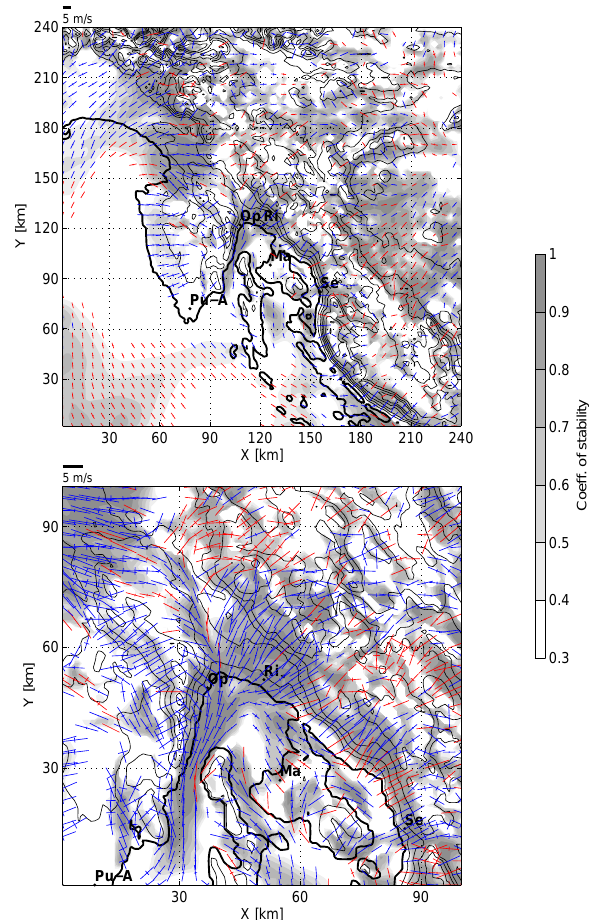
Fig. 9. The axes of averaged ellipses for four modeled multi-day intervals, outer domain (top), inner domain (bottom). The stabil- ity coefficient (indicating the coherence among eccentricities and tilts of main axes) is depicted in gray scale. The CW rotation is displayed in blue, the ACW rotation in